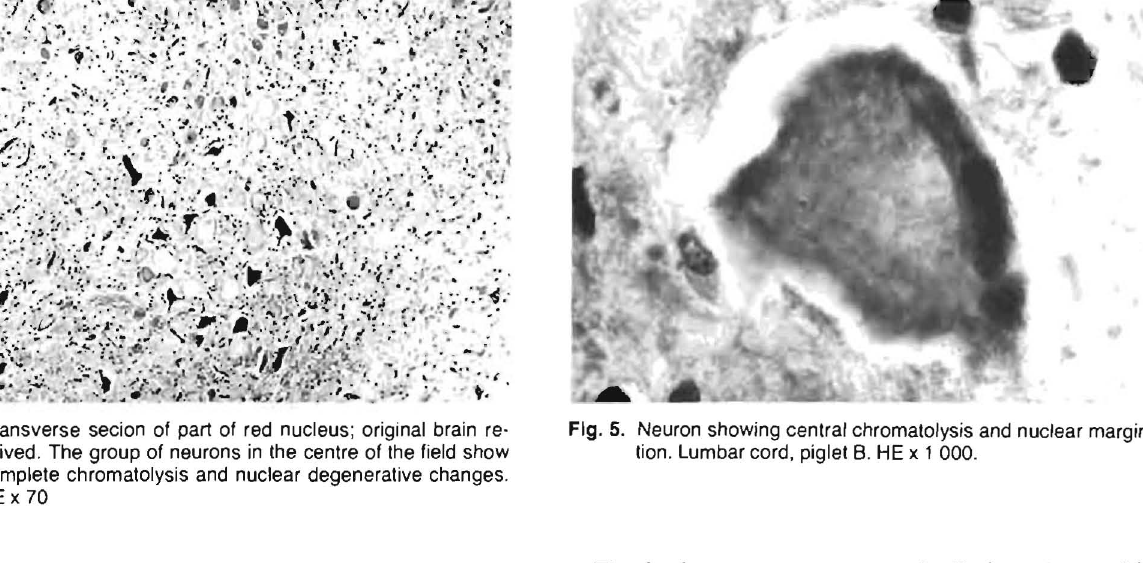
Fig. 3, Transverse secion of part of red nucleus; original brain reo ceived. The group of neurons in the centre of the field show complete chromatolysis and nuclear degenerative changes. HE x 70